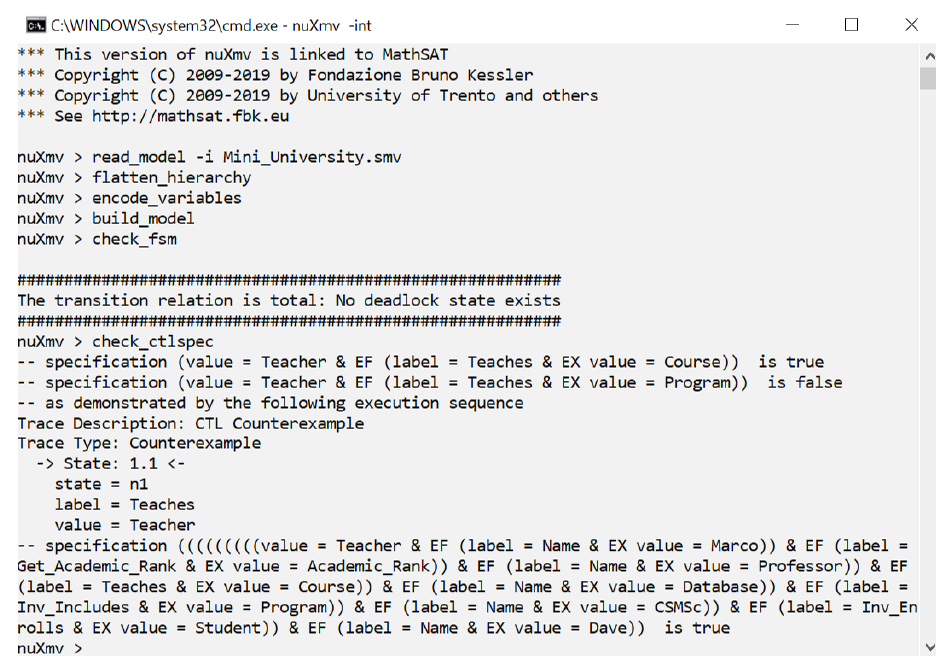
Figure 7. Results of consistency checking based on nuXmv model